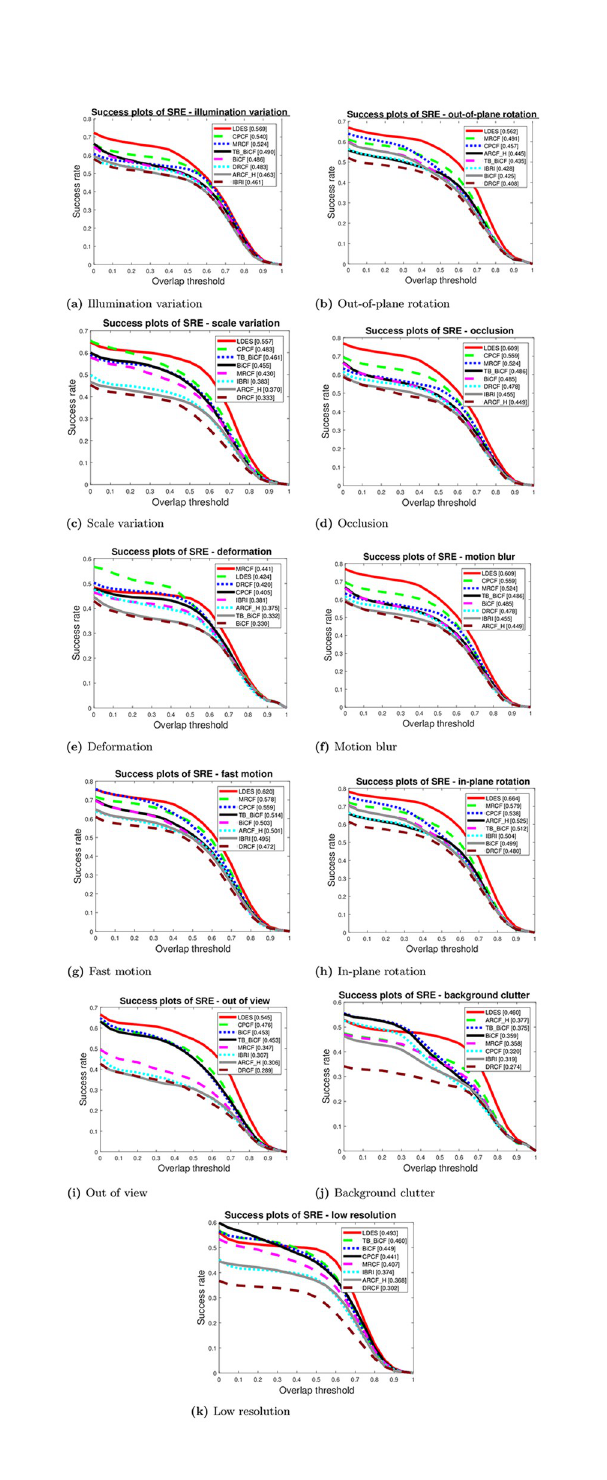
Fig 9. Attribute-based success plots of SRE (illumination variation, out-of-plane rotation, scale variation, occlusion, deformation, and motion blur). (a) Illumination variation. (b) Out-of-plane rotation. (c) Scale variation. (d) Occlusion. (e) Deformation. (f) Motion blur. (g) Fast motion. (h) In-plane rotation. (i) Out of view. (j) Background clutter. (j) Background clutter.